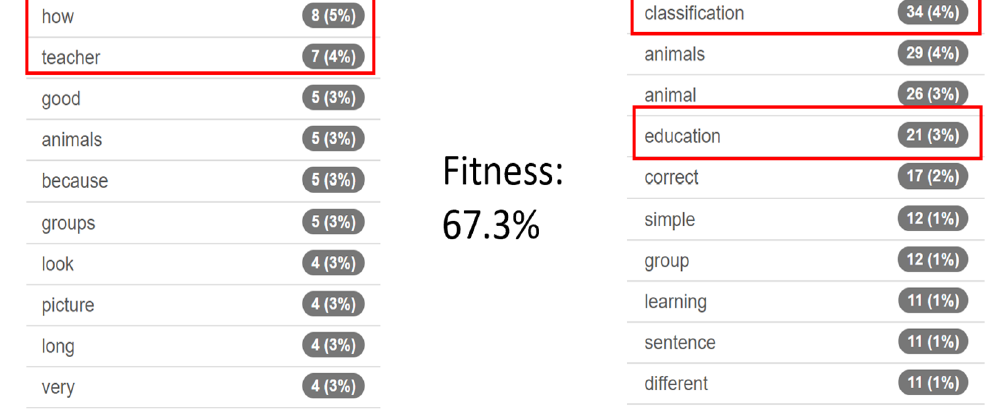
Figure 7. The result of fitness for speech-to-text